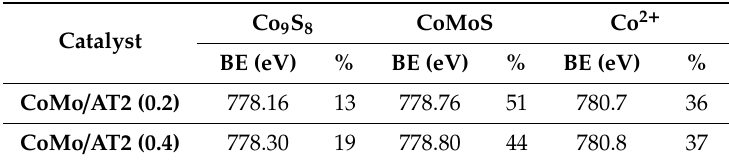
Table 5. Binding energies of the Co 2p 3 / 2 contributions obtained for sulfided 15 wt.% Mo CoMo / AT2 catalysts at Co / (Co + Mo) = 0.2 and